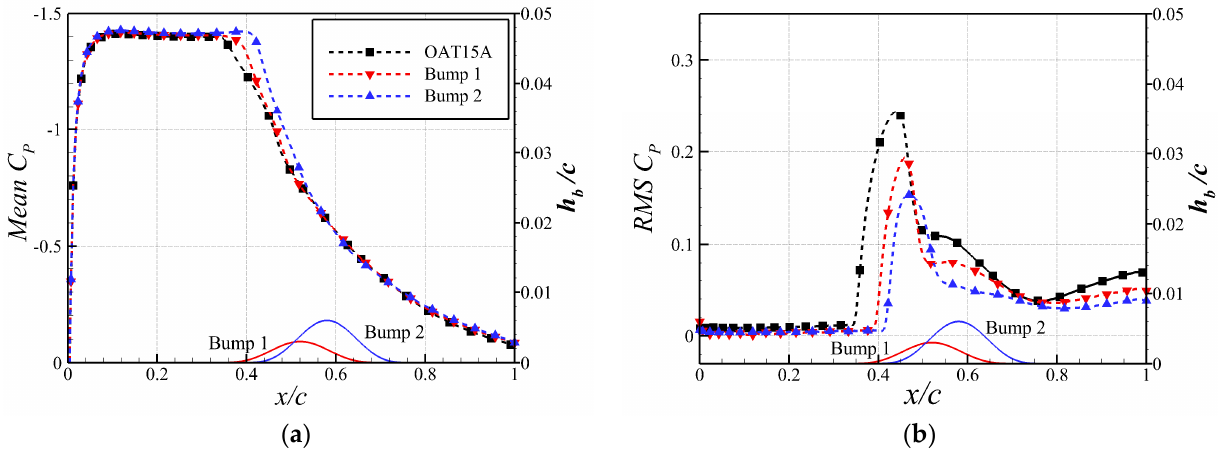
Figure 10. Mean and unsteady characteristics of different configurations. ( a ) Mean C p . ( b ) RMS C p .